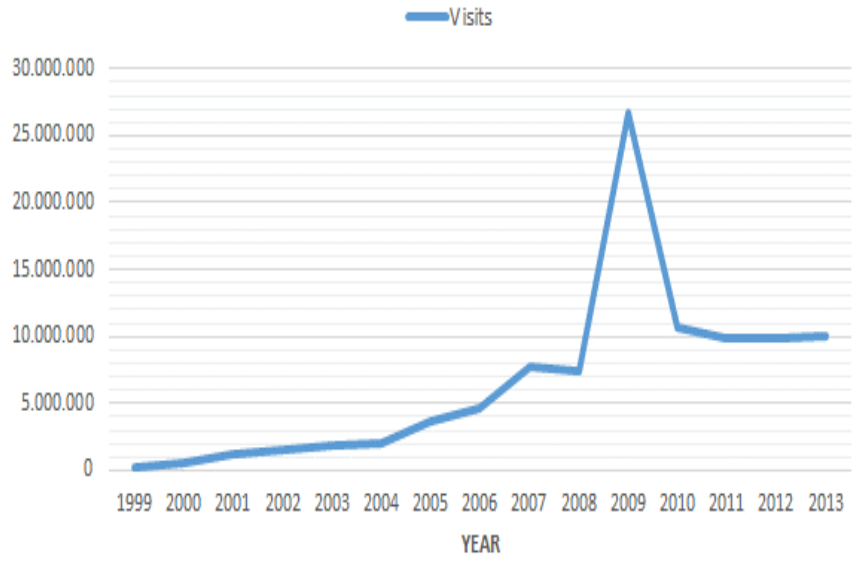
Figure 3. Number of Visits to UNFCCC’s Website Per Year